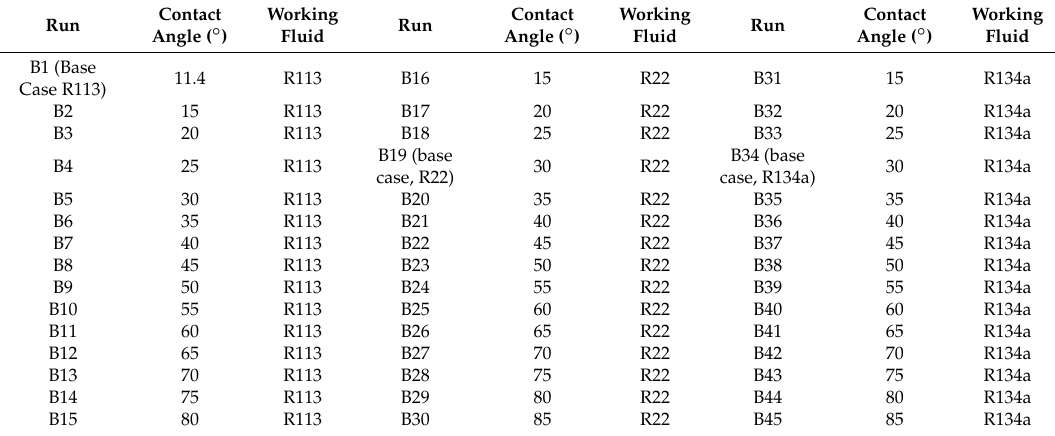
Table 5. Varied parameters in Series B of parametric numerical simulations.